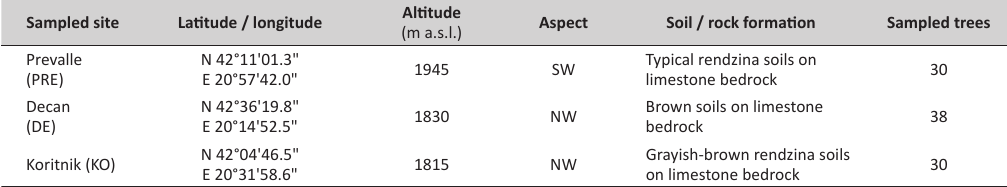
taBLe 1. Site characteristics of the sampled sites